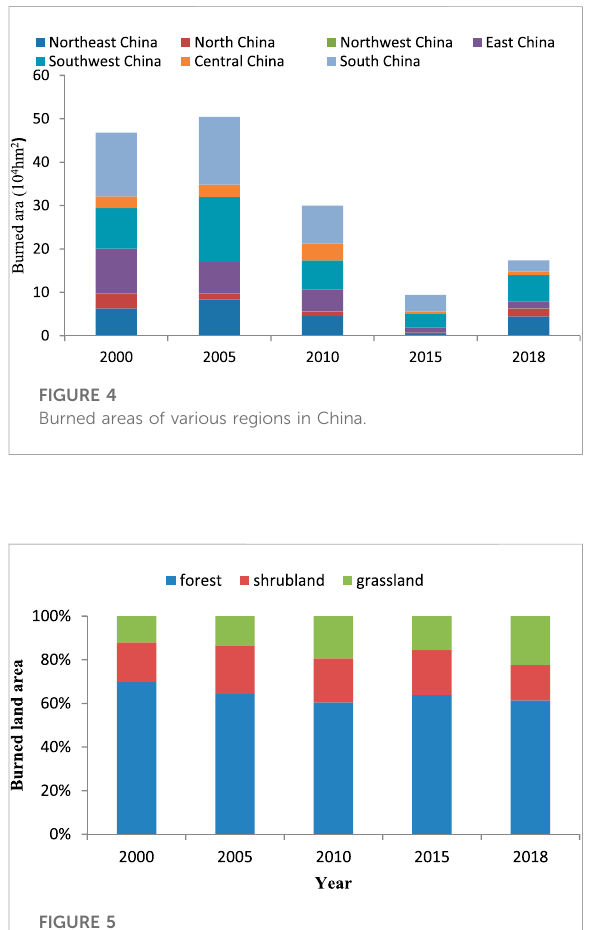
FIGURE 5 Burned area proportion of various vegetation